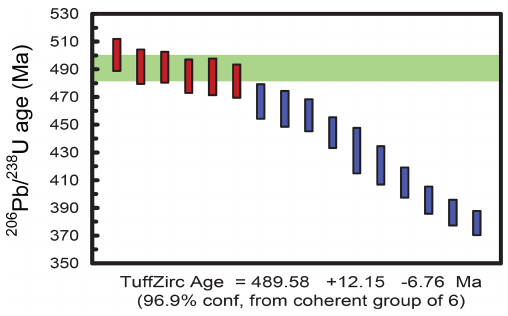
Figure 16. Age of the onset of the oldest HP-HT metamorphic event obtained using the TuffZirc